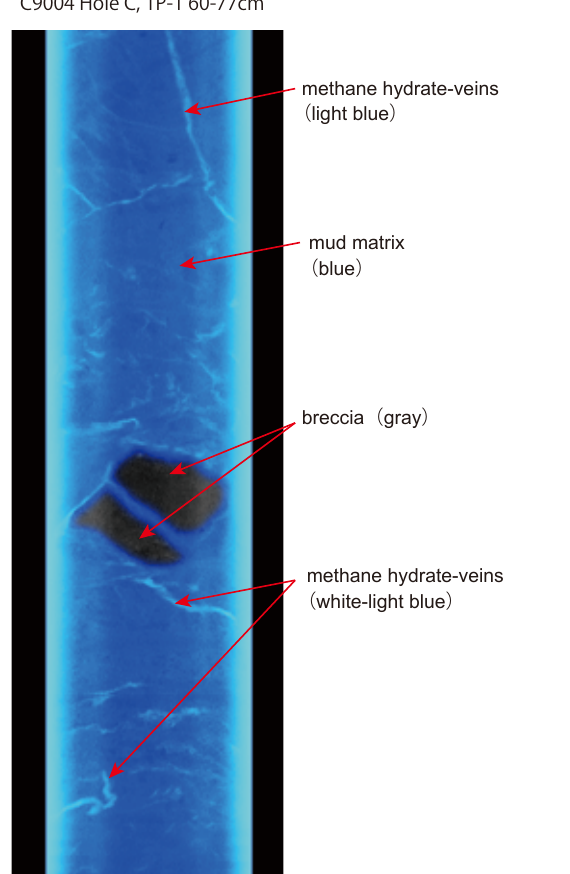
Figure 4. X-ray image of AT1-C-18P from expedition 802 shows clear image of lamina planes in turbidite structures. Sandy layers are highly saturated with methane hydrates. The image covers from 0.4 to 1.5m of the core, and the diameter is